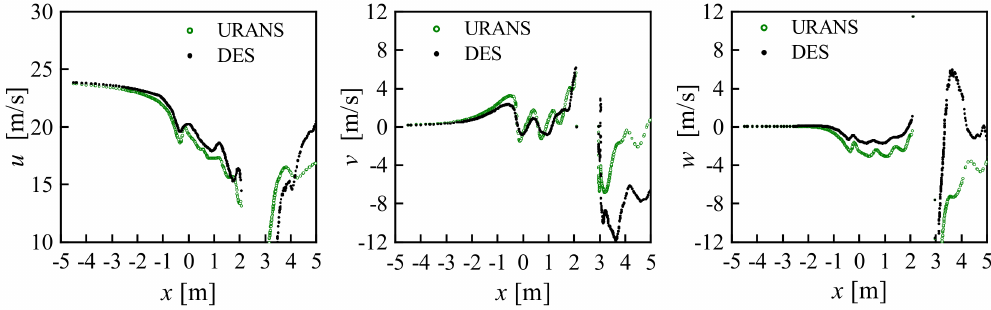
Figure 22. Axial profile of velocity components at y = 1.5 m under wind speed of 24 m/s, TSR =